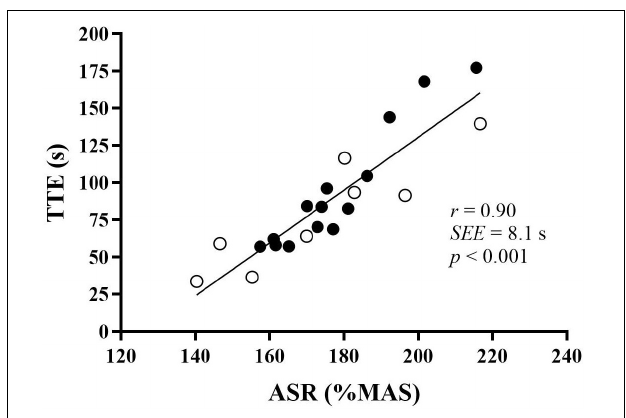
FIGURE 2 | The relationship between ASR and TTE at 130% MAS. Values are ASR (anaerobic speed reserve) in percent (%) on the x -axis and TTE (time to exhaustion) in seconds (s) on the y -axis. Males are denoted in black circles, and females are indicated in white circles. The correlation is statistically significant ( p < 0.001). r , correlation coefficient. SEE, standard error of the estimate. MAS, maximal aerobic